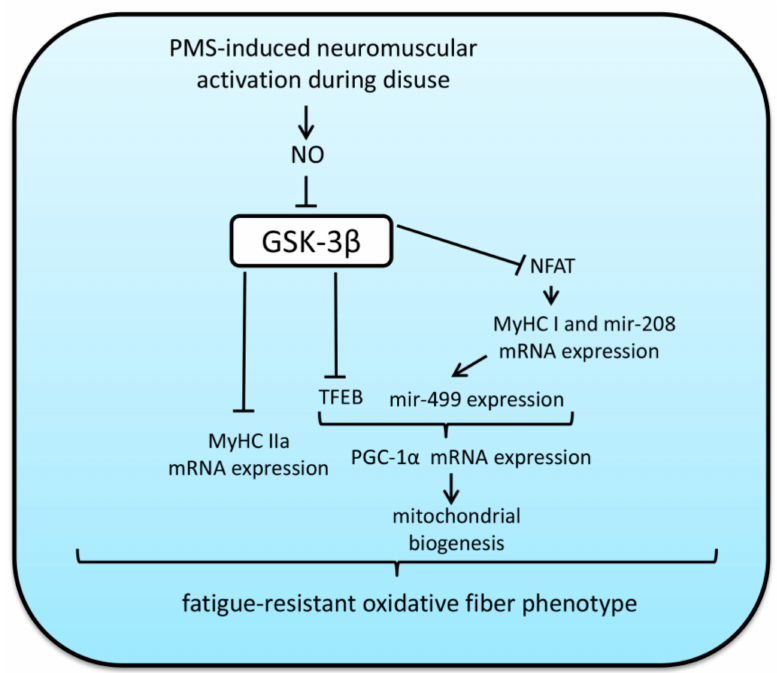
Figure 4. Regulation of myosin phenotype and oxidative capacity by GSK-3 β in unloaded rat soleus muscle. Arrows indicate stimulatory signals, whereas T bars represent inhibitory signals. Plantar mechanical stimulation (PMS) leads to GSK-3 β inactivation via NO-dependent pathway. GSK-3 β blocks transcriptional activities of NFAT and TFEB transcription factors that can lead to downreg- ulation of both PGC-1 α and slow MyHC I and subsequent decrease in mitochondrial biogenesis. Thus, NO-dependent inactivation of GSK-3 β facilitates fatigue-resistant oxidative phenotype of skeletal muscle fibers. NO—nitric oxide, MyHC—myosin heavy chain, PKG—protein kinase G, NFAT– nuclear factor of activated T-cells, mir-208—micro-RNA 208, TFEB—transcription factor EB, PGC1 α —peroxisome proliferator-activated receptor gamma coactivator 1-alpha, MyHC—myosin heavy